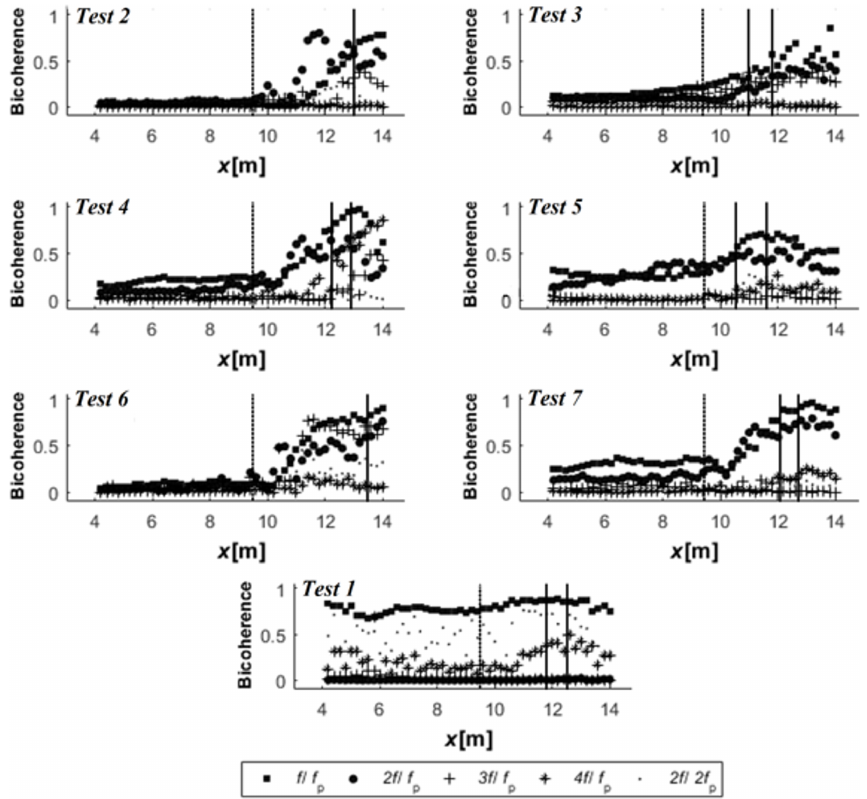
Figure 11. Spatial variation of the wavelet-based bicoherence among harmonics. The two vertical solid lines and the dotted line respectively indicate the breaking region and the toe of the